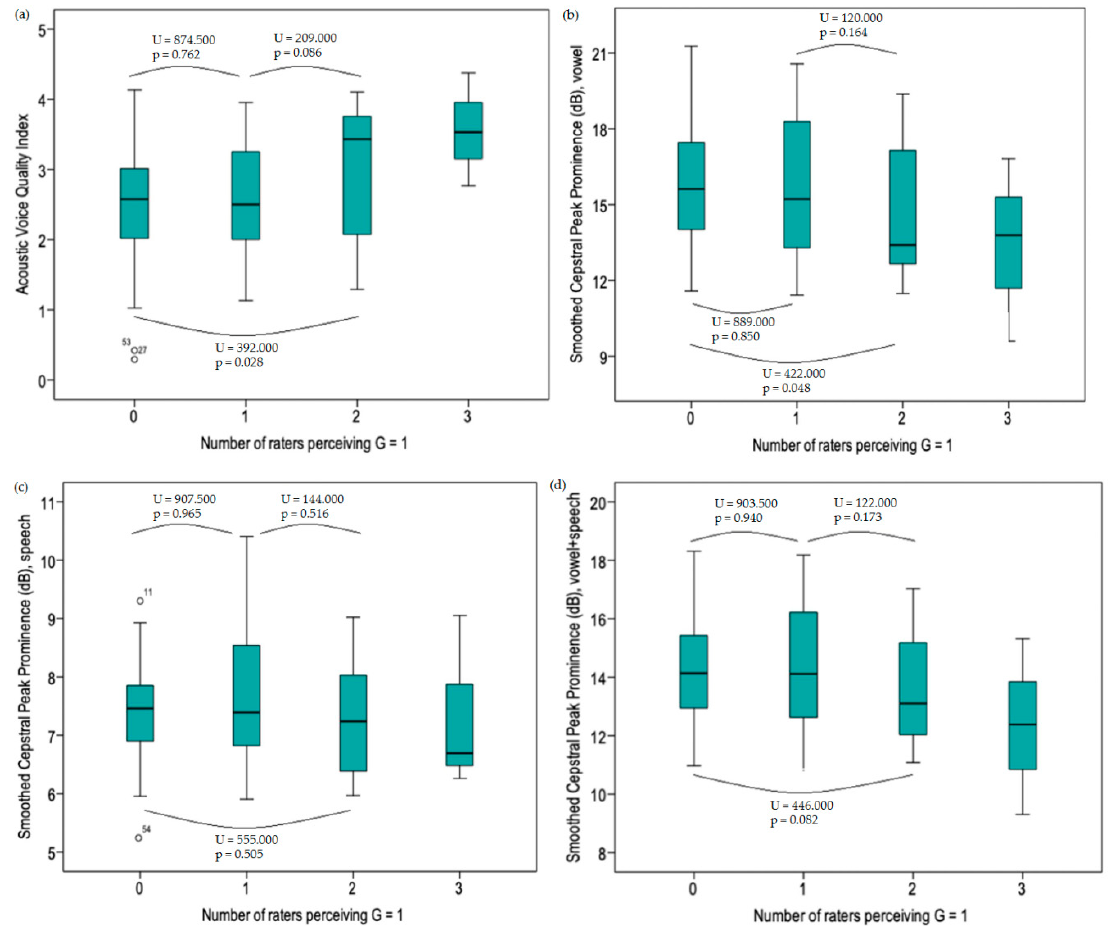
Figure 3. ( a – d ) Di ff erences between mean AVQI and CPPS values of the normal cohort and sub-levels Figure 3. Differences between mean AVQI and CPPS values of the normal cohort and sub-levels of of subclinical slight dysphonia presented by box plots with corresponding subclinical slight dysphonia presented by box plots with corresponding significance.